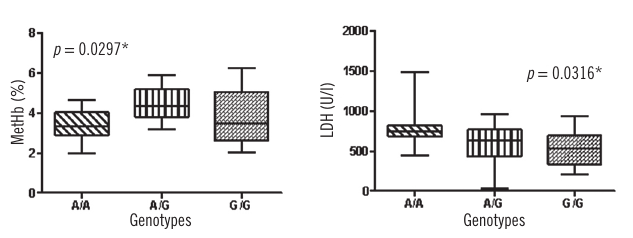
figurE 1 − Hemolysis biomarkers according to BCL11A genotypes in region rs7557939 The p -values were obtained by one-way Anova with the Tukey post-hoc test. AA: n = 11; A/G: n = 20; GG: n = 13; MetHb: significant difference between groups A/A and A/G, and LDH between groups A/A and G/G, which is significant at the 0.05 level. Anova: analysis of variance; MetHb: methemoglobin; LDH: lactate